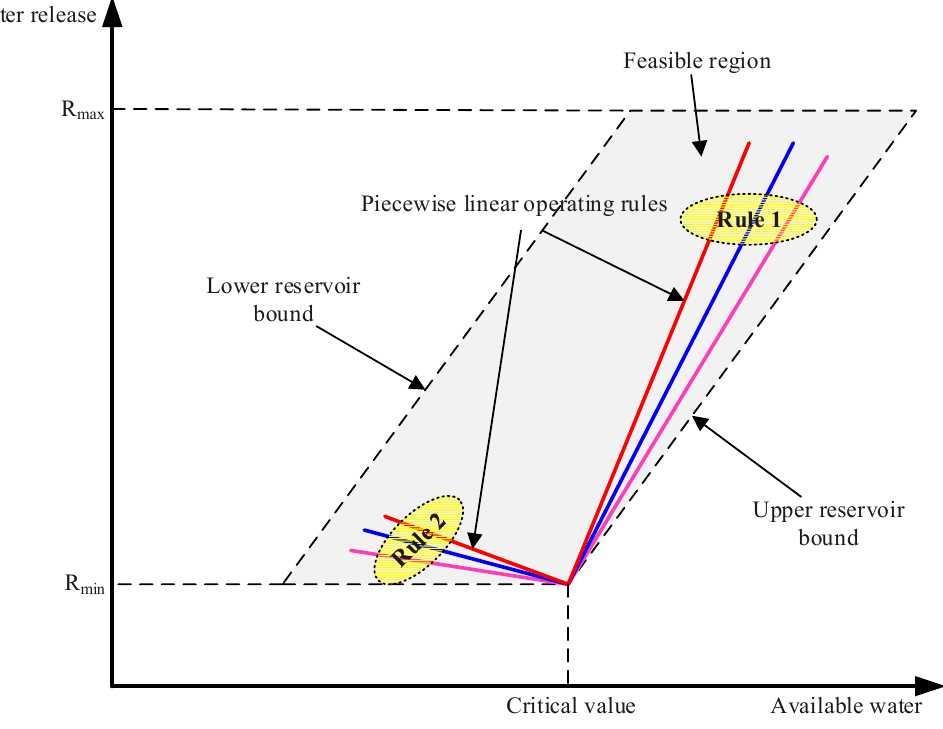
Figure 2. General form of the piecewise linear operating rules.